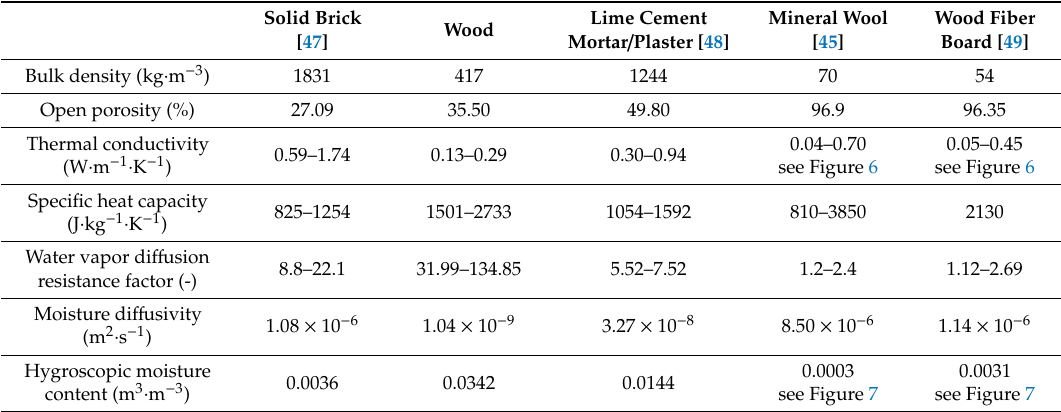
Table 1. Summary of material